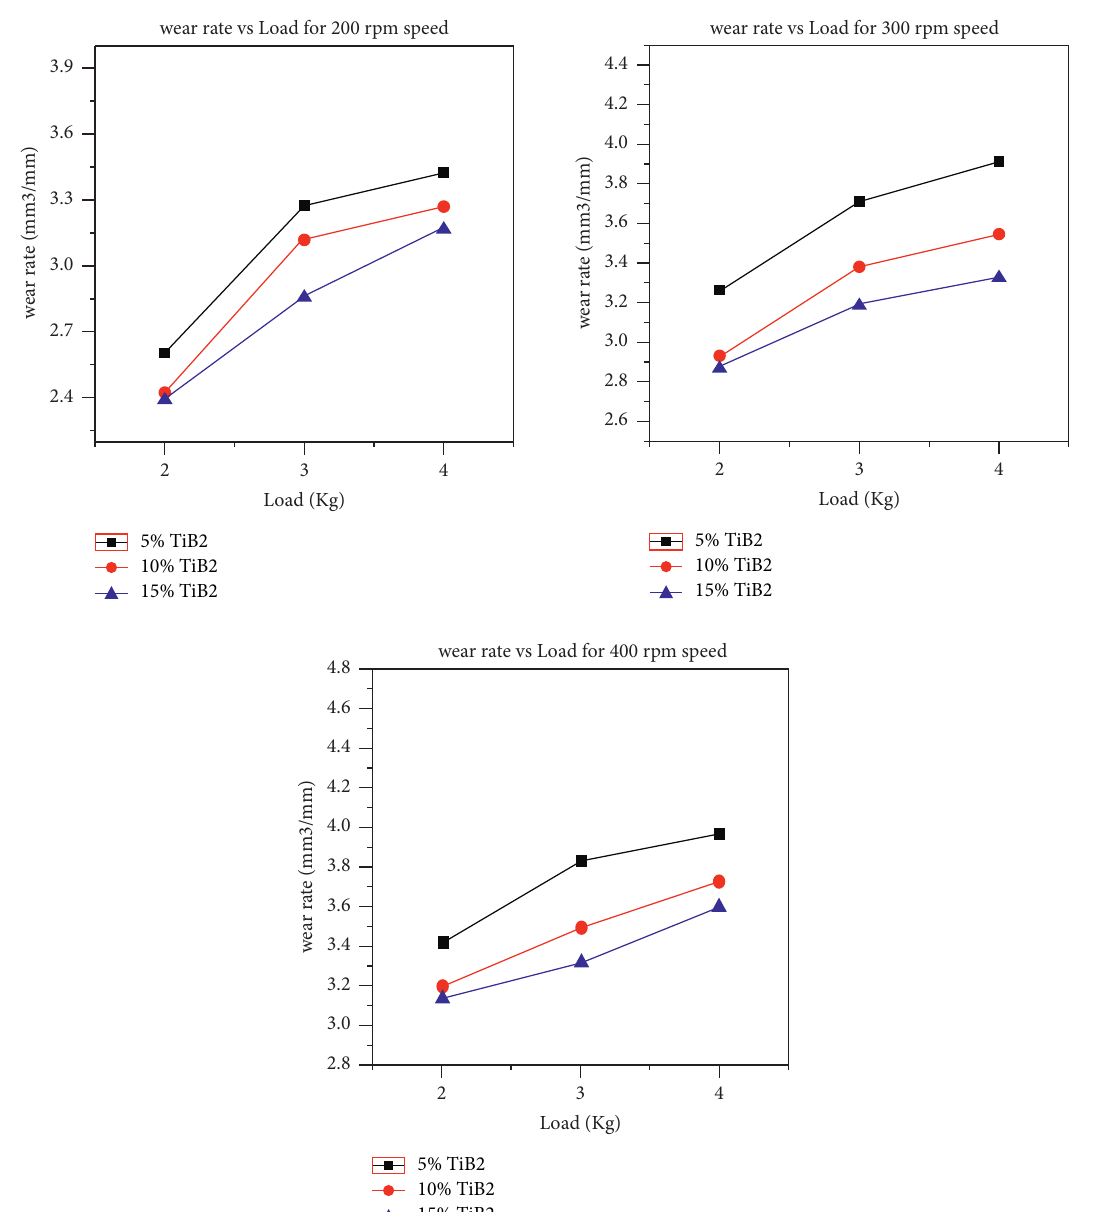
Figure 9: Wear rate